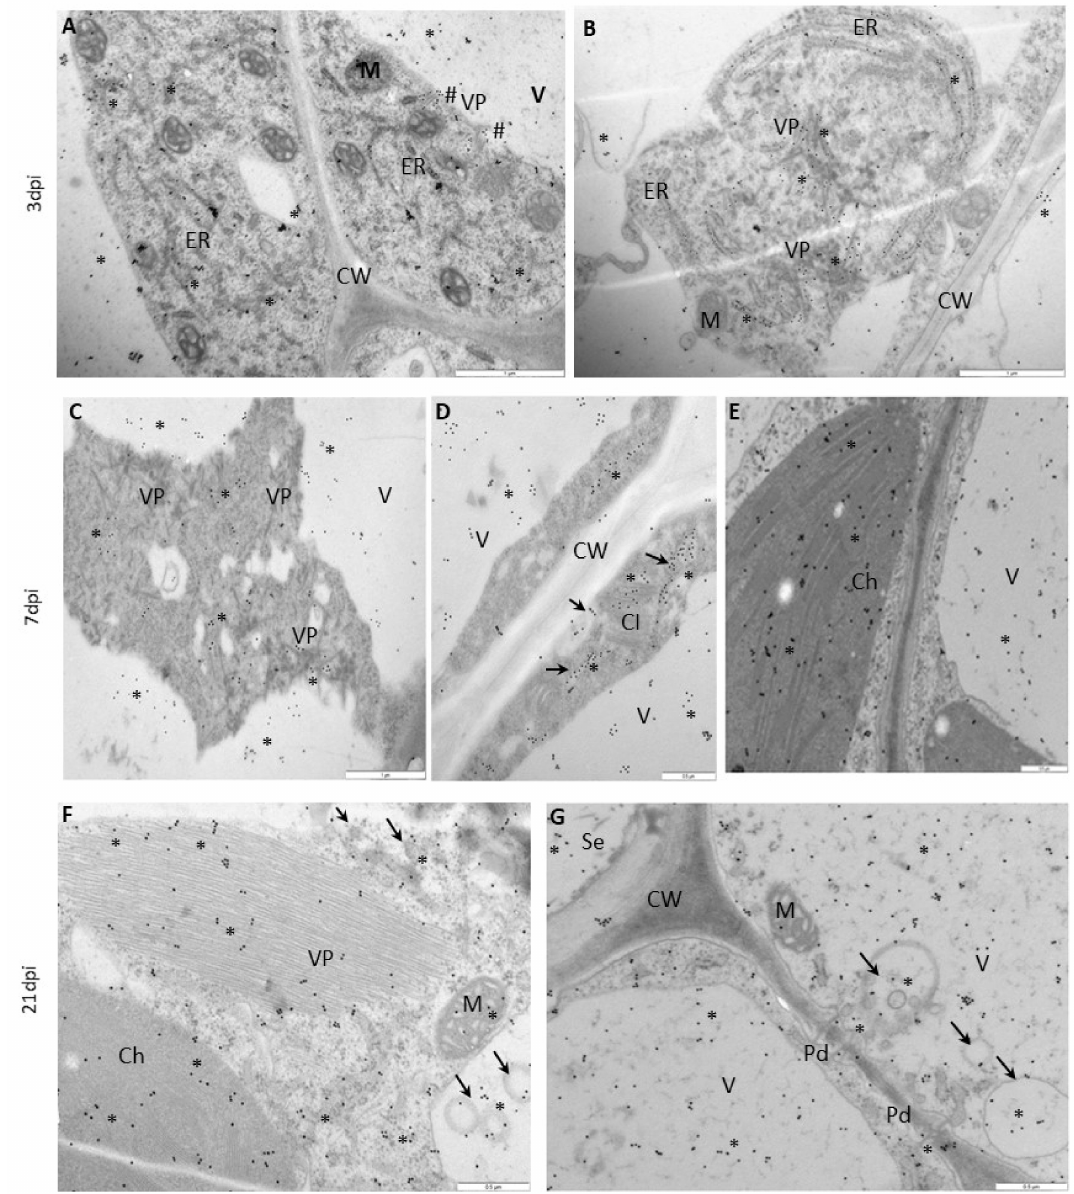
Figure 5. Immunogold labeling of PVY NTN -NIb in susceptible Irys ( A , B ) at 3 dpi, ( C , E ) at 7 dpi, and ( F , G ) at 21 dpi. ( A ) NIb signal (*) around the ER in the cytoplasm and vacuole (V) of phloem parenchyma cells. Gold granules around virus particles (VP, #) near tonoplasts. Scale bar: 1 µ m. ( B ) NIb signal (*) on virus particles (VP) and the ER in mesophyll cells. Scale bar: 1 µ m. ( C ) NIb (*) around virus particles (VP) and in the vacuoles (V) of mesophyll cells. Scale bar: 1 µ m. ( D ) NIb (*) on membranous structures (arrow), around virus cytoplasmic inclusion (CI) bodies, and in vacuoles (V) in palisade mesophyll cells. Scale bar: 0.5 µ m. ( E ) NIb (*) in chloroplasts (Ch) and vacuoles (V) in mesophyll cells. Scale bar: 0.5 µ m. ( F ) NIb gold granules (*) in the cytoplasm and virus particles (VP), in chloroplasts (Ch), and vesicular structures (arrows) of cytoplasm and vacuoles (V). Scale bar: 0.5 µ m. ( G ) NIb gold granules (*) in plasmodesmata (Pd) and along vesicular structures (arrows) near plasmodesmata. NIb also occurs inside sieve elements (Se) and in the vacuoles of phloem parenchyma cells. Scale bar: 0.5 µ m. CW—cell wall,